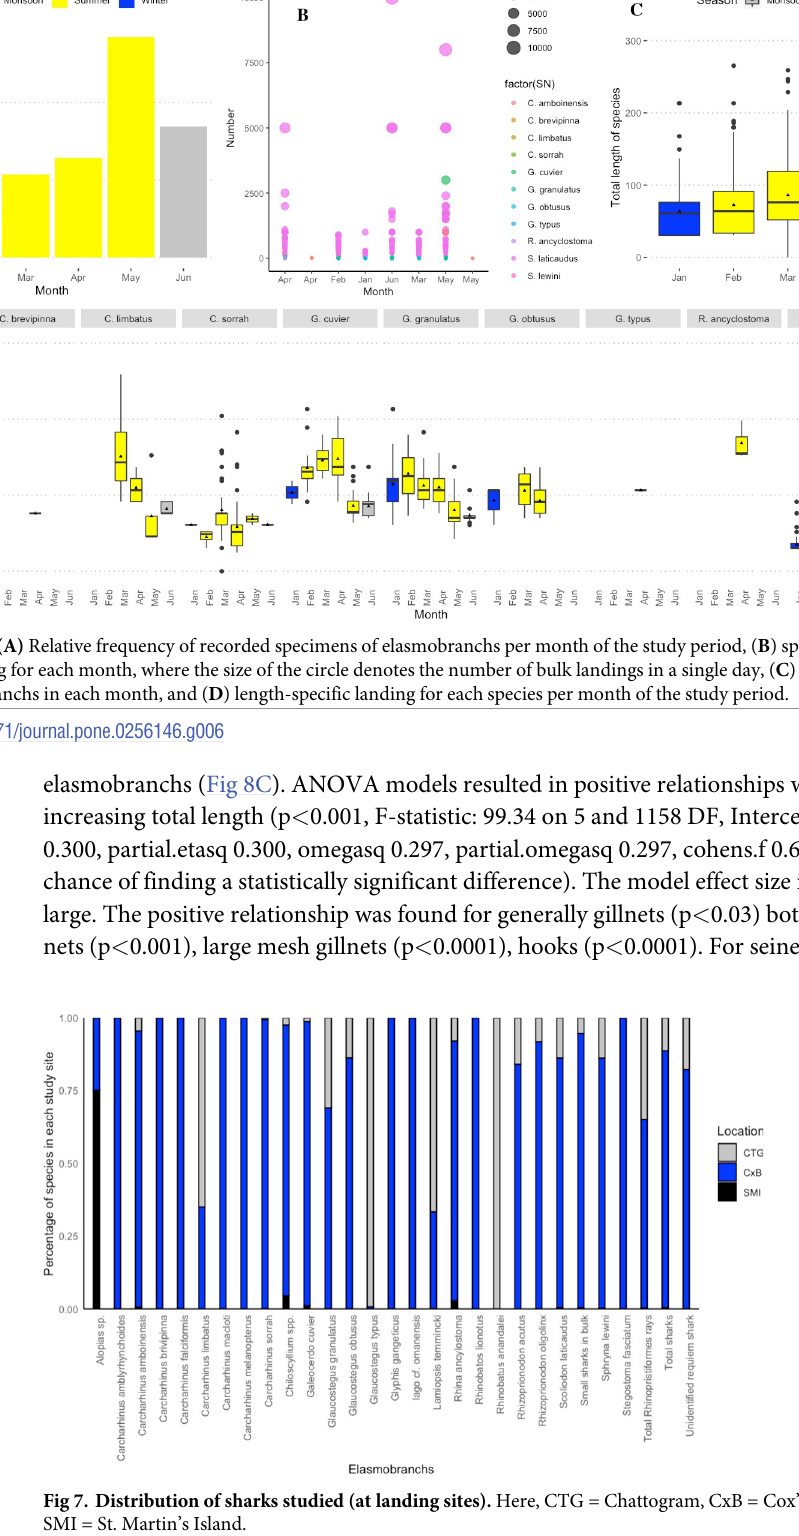
Fig 7. Distribution of sharks studied (at landing sites). Here, CTG = Chattogram, CxB = Cox’s Bazar and SMI = St. Martin’s Island.